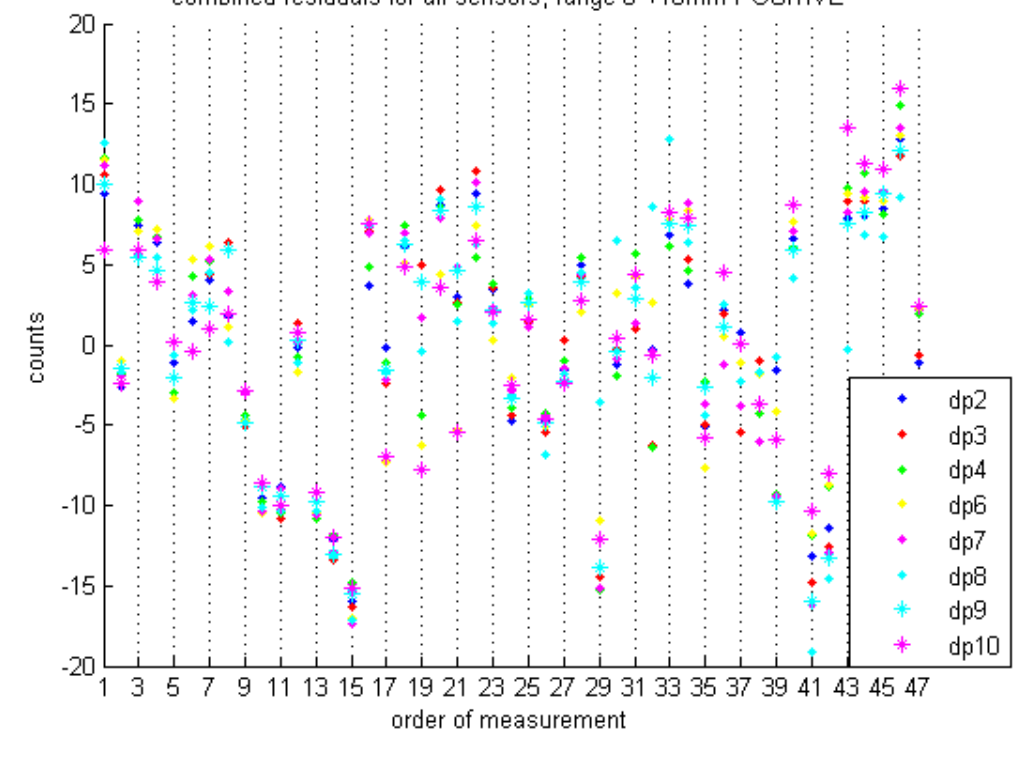
Figure 8. Residuals between individual measurements and a linear calibration curve fitted to all calibration data obtained during five experiments over a period of three weeks in August